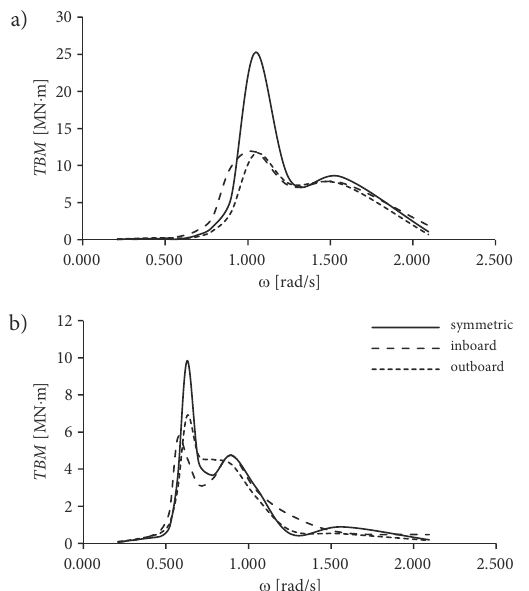
Figure 10. RAOs of transverse bending moments TBM in: